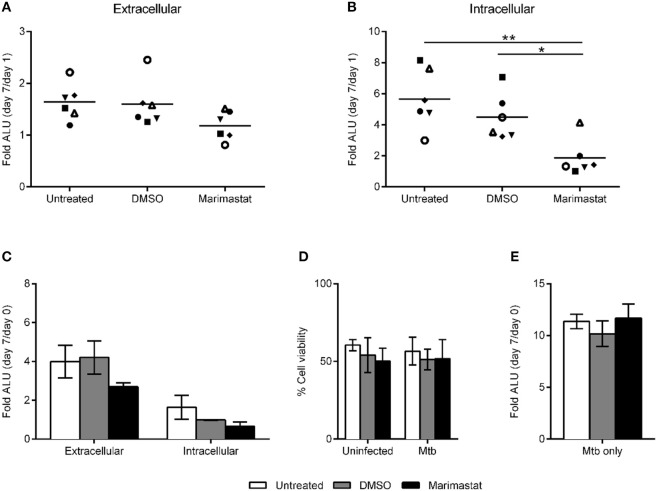
Effect of MMP inhibition on bacterial growth. Tissue models were left untreated, mock-treated (DMSO) or treated with 200 nM marimastat, infected with Mtb-lux, digested and analyzed with respect to bacterial replication after 1 and 7 days post infection. The fold change in bacterial numbers expressed as the ratio of arbitrary luminescence units (ALU) from day 7/Day 1 (n = 6) was determined in the extracellular matrix (A) and intracellularly (B). (C) Macrophage monocultures were treated as indicated and infected with Mtb-lux. ALU was determined in supernatants (extracellular) and in cell lysates (intracellular) at day 0 and 7 and the fold change in bacterial numbers was determined by calculating the ratios of ALU at day 7/day 0 (n = 3). (D) The viability of these macrophages was determined by measuring the uptake of calcein-AM. (E) Broth cultures of Mtb-lux were left untreated or incubated with DMSO or marimastat and the fold change in bacterial numbers expressed as the ratio of arbitrary luminescence units (ALU) from day 7/day 0. Statistical analysis was done using 1-way ANOVA with Tukey's multiple comparisons test between groups (A,B,E, *p ≤ 0.05, **p ≤ 0.01) and 2-way ANOVA with Sidak's multiple comparisons test within and between groups (C,D, error bars are SEM).